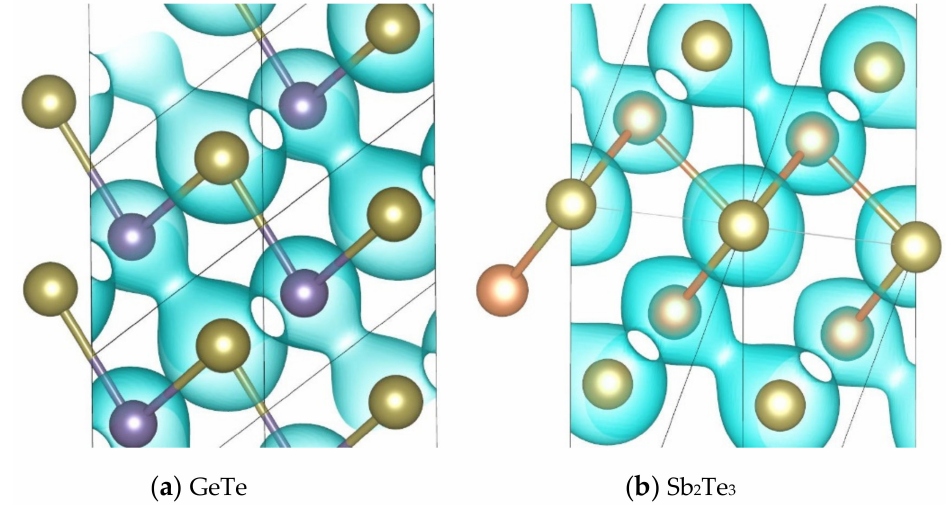
Figure 5. The bonds at the second NN between unlike atoms with the isosurface at − 0.035 electrons per bohr 3 in the spatial valence charge density of ( a ) GeTe and ( b ) Sb 2 Te 3